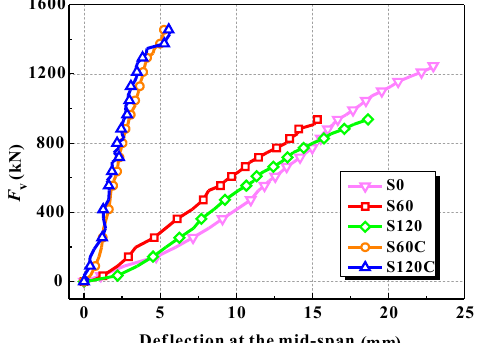
Figure 15. Load versus mid-span deflection.